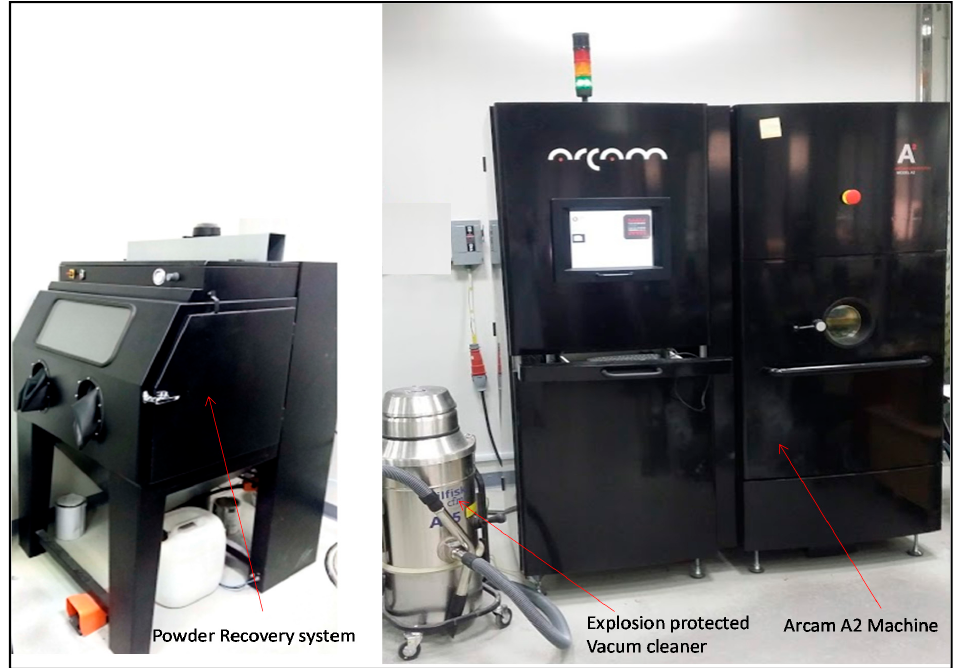
Figure 16. ( a ) Schematic diagram of the electron beam melting (EBM) A2 machine and ( b ) scanning electron microscopic image of Ti6Al4V powder.